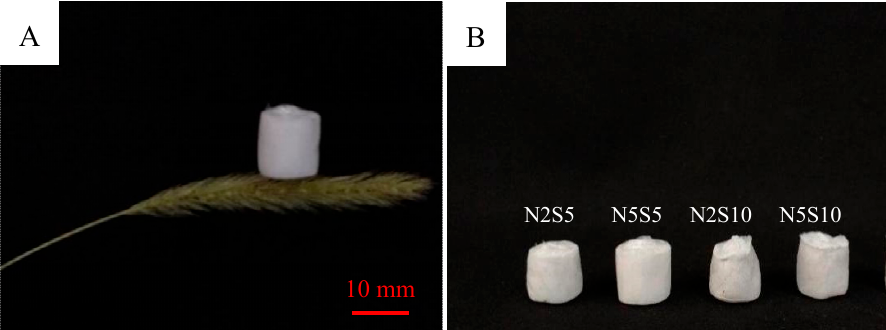
Figure 7. ( A ): macro figure of aerogel; ( B ): macro figure of nanocellulose aerogels prepared under; different processing conditions (N2S5: 2 wt% NaOH and 5 min sonication, N5S5: 5 wt% NaOH and 5 min sonication, N2S10: 2 wt% NaOH and 10 min sonication, N5S10: 5 wt% NaOH and 10 min sonication).